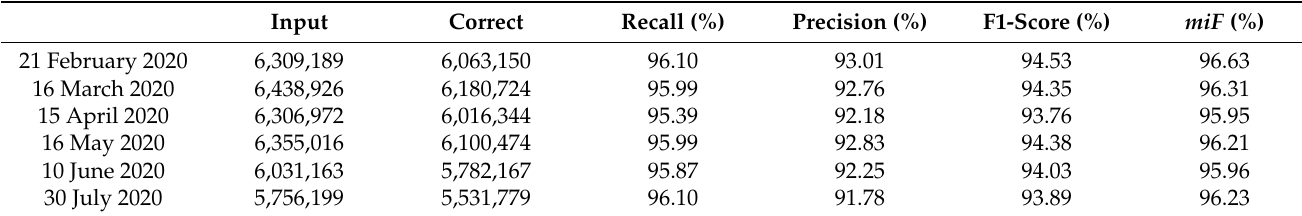
Table 7. Summary of the FCDN_CSM nighttime predictions for six days’ data.